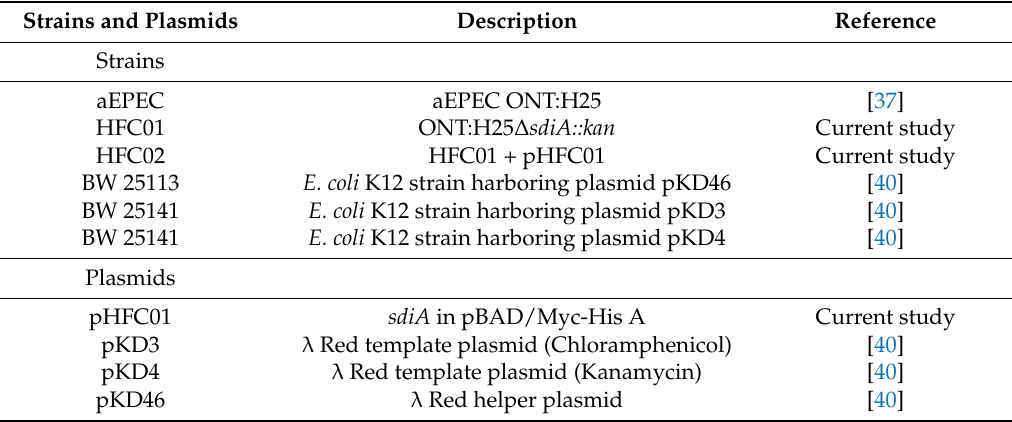
Table 1. Escherichia coli strains and